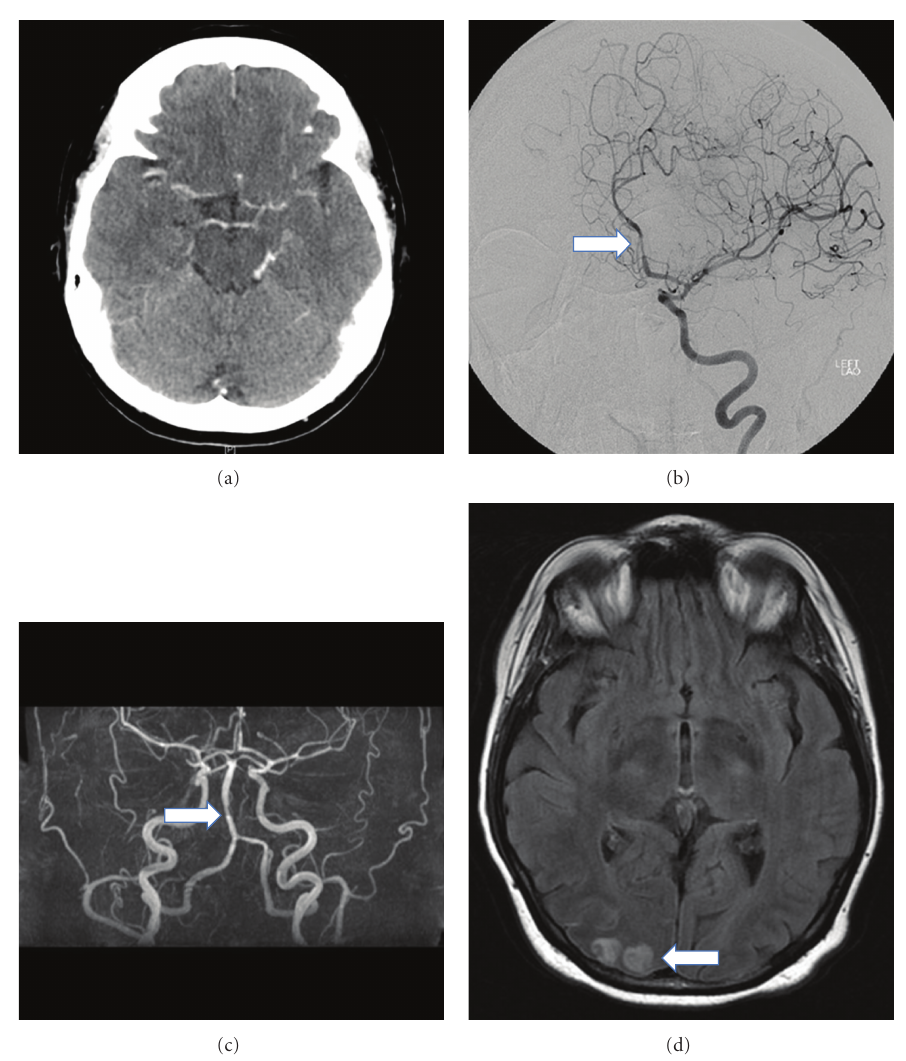
Figure 2: Neuroimaging in a case of RCVS. Neuroimaging of a 61-year-old female with RCVS. (a) CT angiography demonstrated no evidence of vasospasm. (b) DSA demonstrated di ff use areas of focal segmental narrowing a ff ecting both the anterior and posterior circulation, particularly in the A2 segment of the left anterior cerebral artery (arrow). (c) MRA showed predominantly peripheral focal segmental spasm, though not as clearly as the DSA (d) MRI 6 weeks after presentation reveals high T2 signal representing right occipital cortical infarcts. CT: computerised tomography; DSA: digital subtraction angiogram; MRA: magnetic resonance angiogram; MRI: magnetic resonance